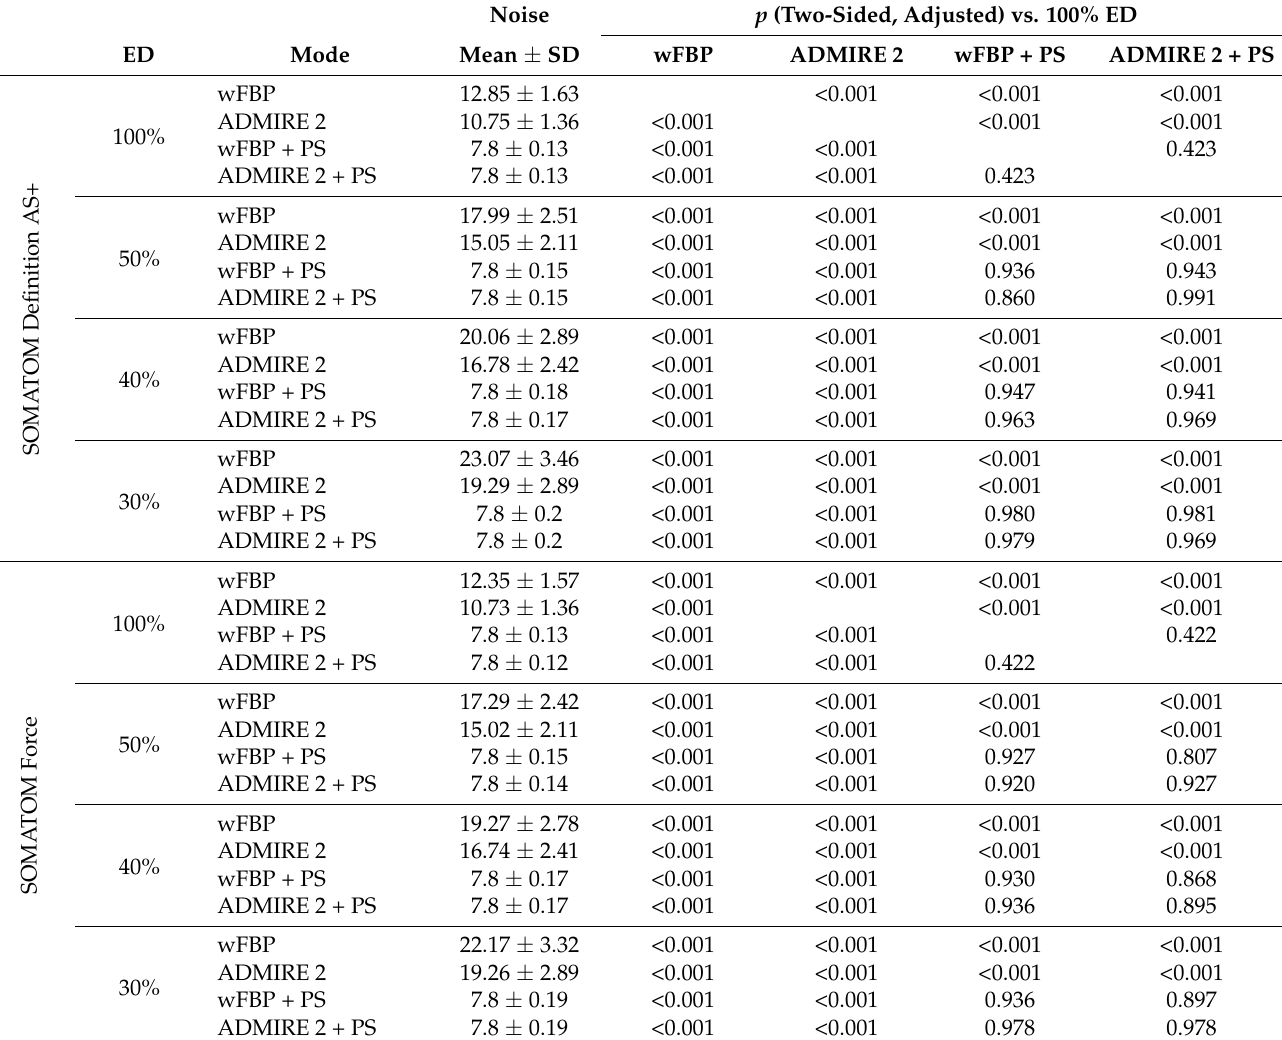
Table 4. Mean noise levels and pairwise noise comparisons. Noise p (Two-Sided, Adjusted) vs. 100%